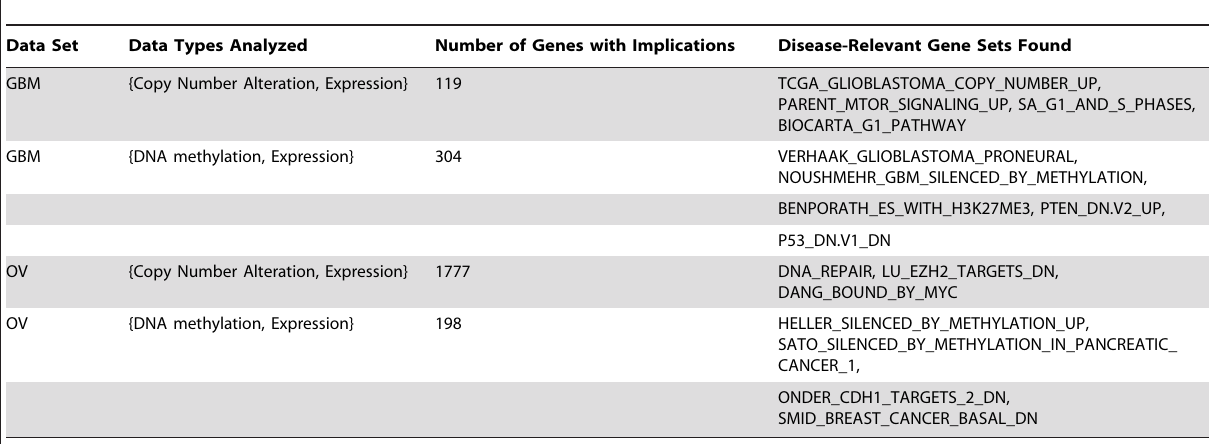
Table 6. Summary of cis -regulatory analysis using Boolean